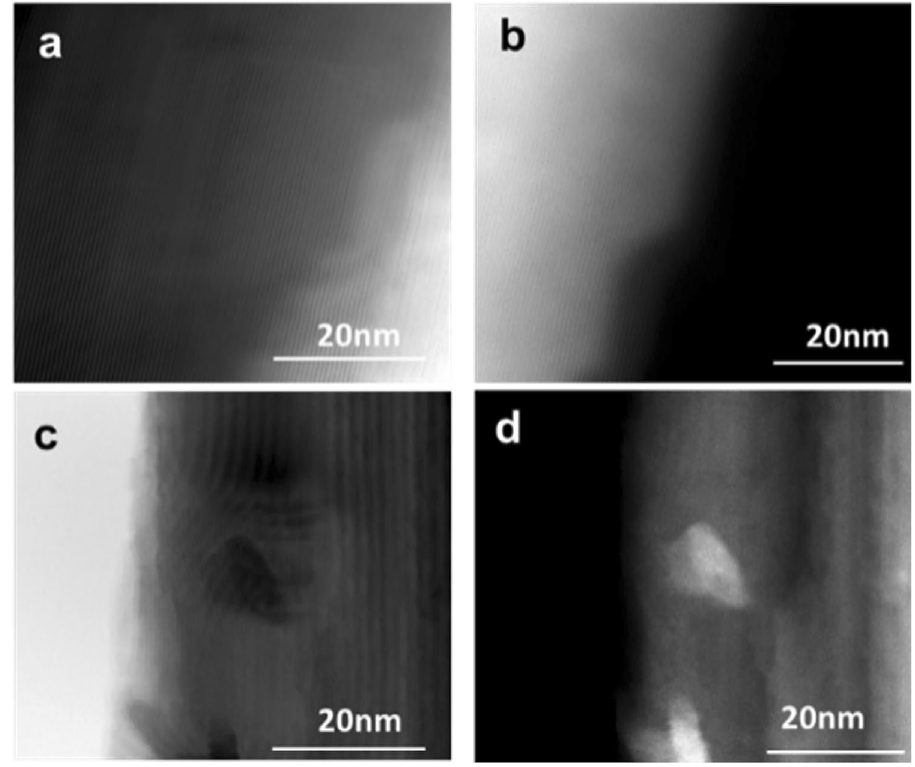
Figure 6. STEM images of Ga 2 O 3 nanowire growth on quartz substrate at 1000 °C. ( a ) Bright field (BF) ( b ) high-angle annular dark-field (HAADF) STEM images of Ga 2 O 3 nanowire without Ag catalyst. ( c ) Bright field (BF) ( d ) high-angle annular dark-field (HAADF) images of Ag NPs at the interface of Ga 2 O 3 nanowire. The nanoparticle was bright due to